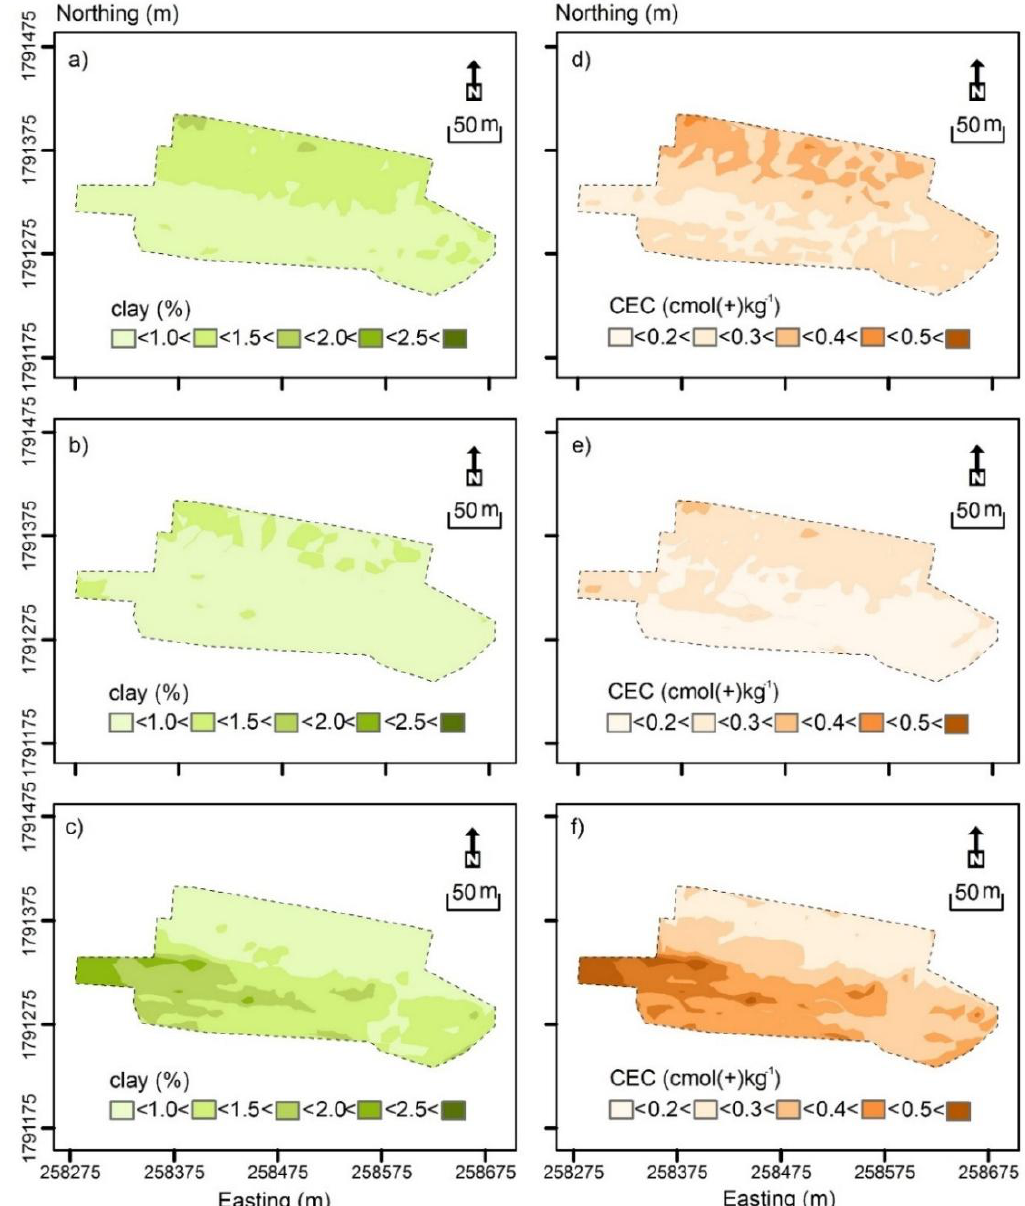
Figure 9. Contour plots of the prediction interval (PI) of the predictions made for clay (%) at different depths including ( a ) topsoil (0–0.3 m), ( b ) subsurface (0.3–0.6 m) and ( c ) subsoil (0.6–0.9 m); and cation exchange capacity (CEC—cmol(+)/kg) in the ( d ) topsoil, ( e ) subsurface and ( f ) subsoil.